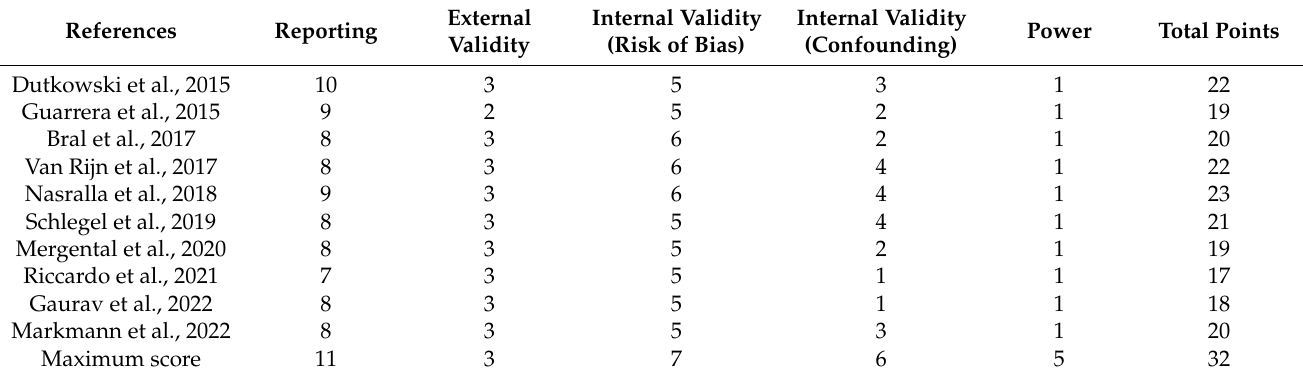
Table 1. Quality assessment based on the downs and black checklist.